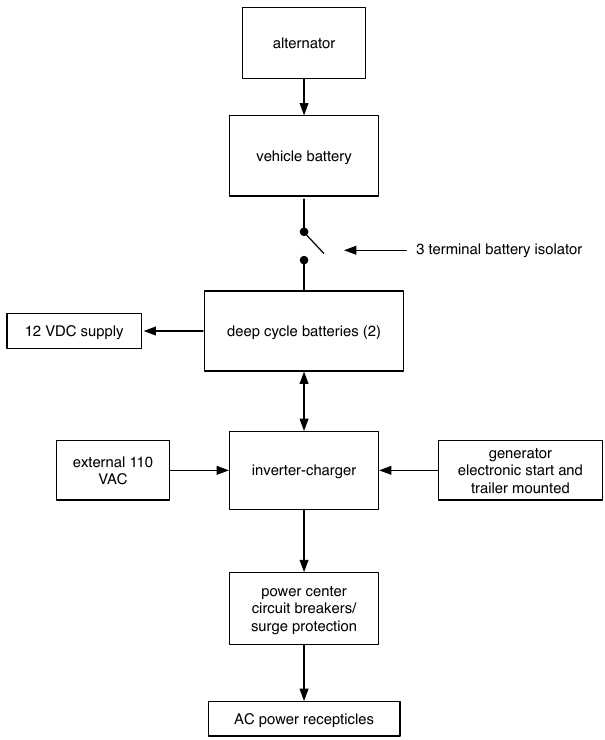
Figure 2. Diagram of the electrical system components and connec-